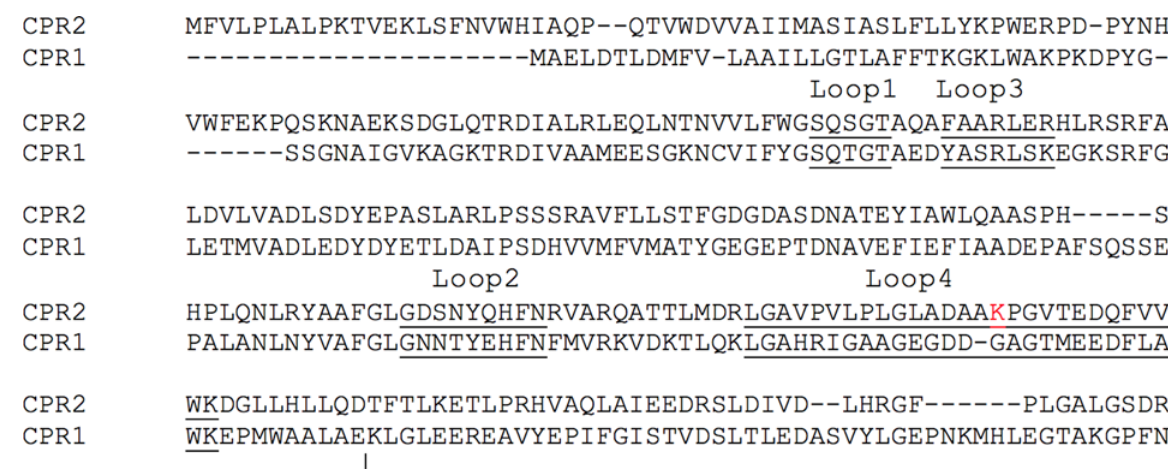
Fig 8. Amino acid alignment of 4 FMN-binding domains of Gs CPR2 and Gs CPR1, which interact with Gs CYP630B18. Loops are underlined and in bold. Lys 322 in loop 4 is marked in red.